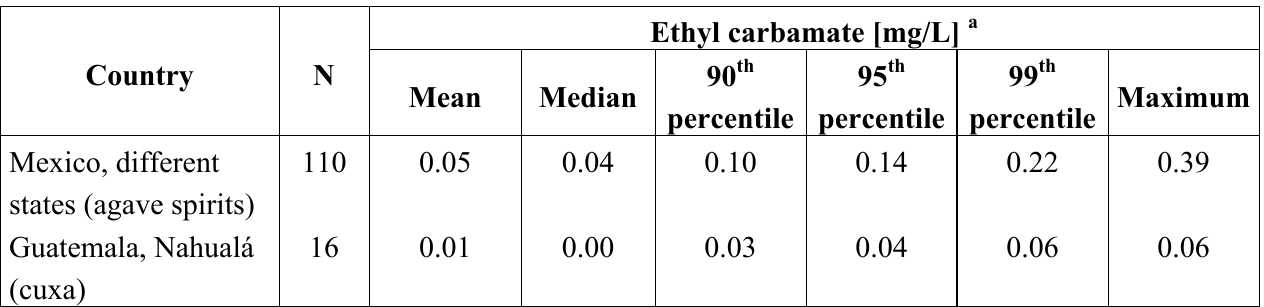
Table 2. Ethyl carbamate concentrations in alcoholic beverages from Mexico and Guatemala.